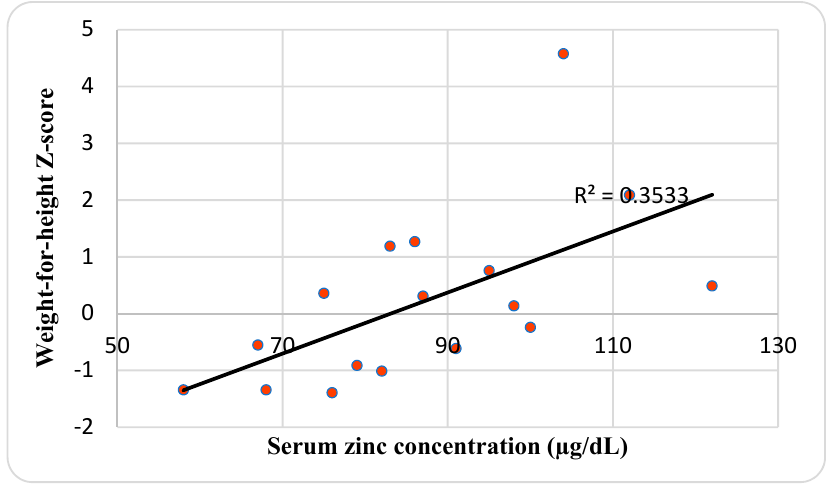
Figure 2. Relationship between serum zinc concentration and Body Mass Index Z ‐ score.